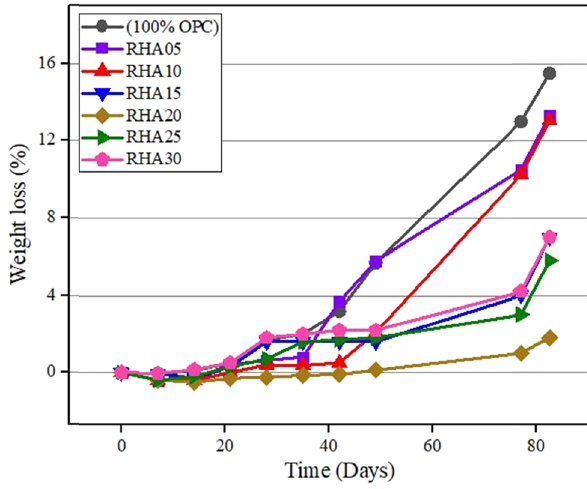
Figure 13: Weight losses in 5% H 2 SO 4 [ 34 ] .